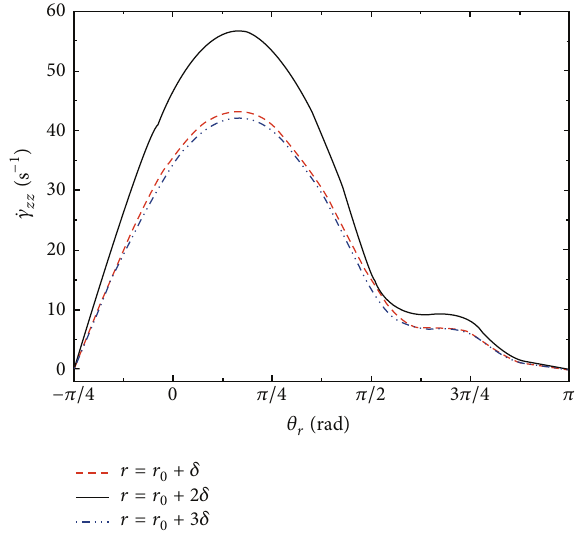
Figure 5: The axial tensile strain rate of melt moving in a chamber of VCPU: discharge